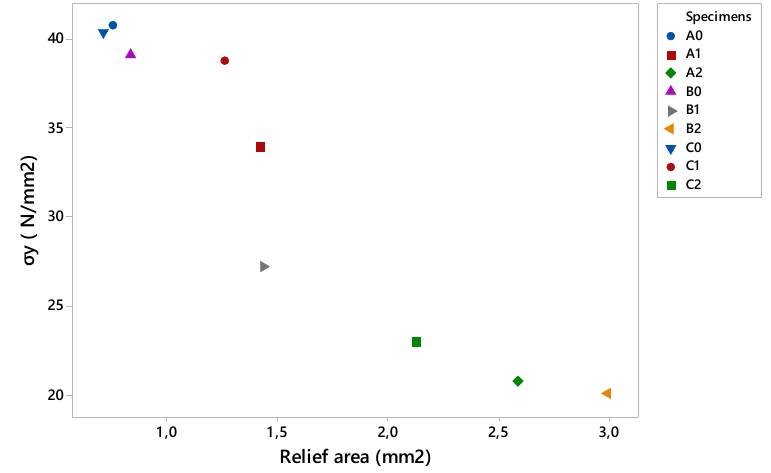
Figure 13. Data of the yield stress with respect to the section of the relief.